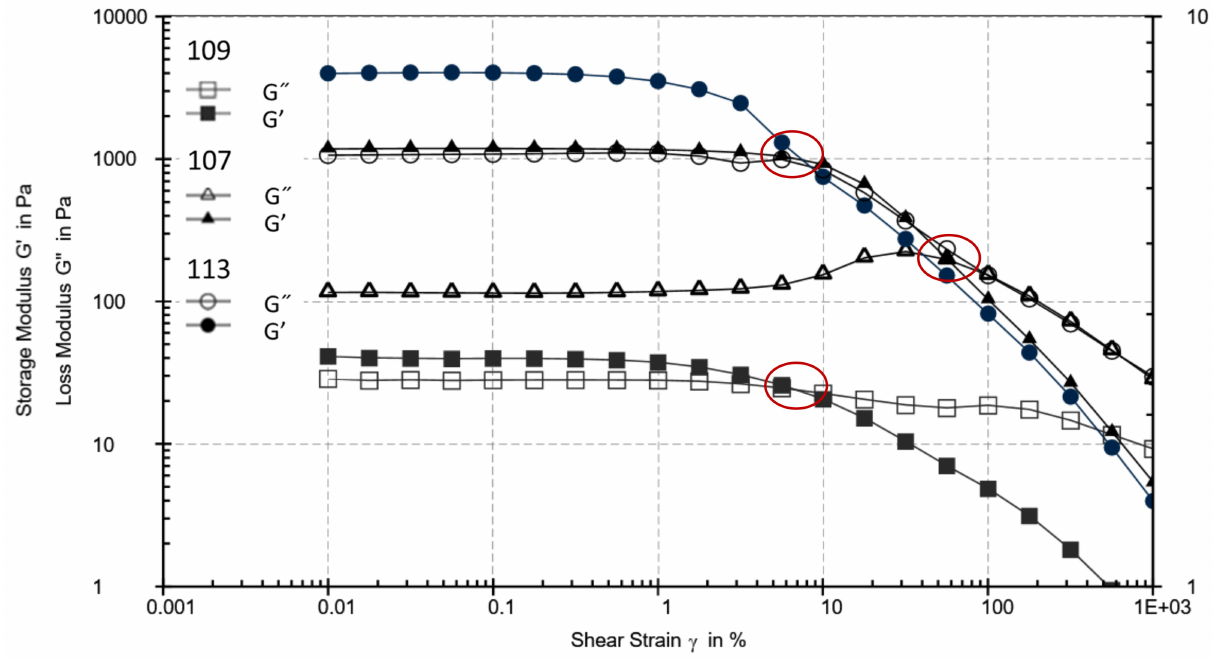
Figure 4. Viscoelastic characterization of the three extreme products (107, 109 and 113) of the PCA (Figure 6). The crossover of each product is marked by a red circle.